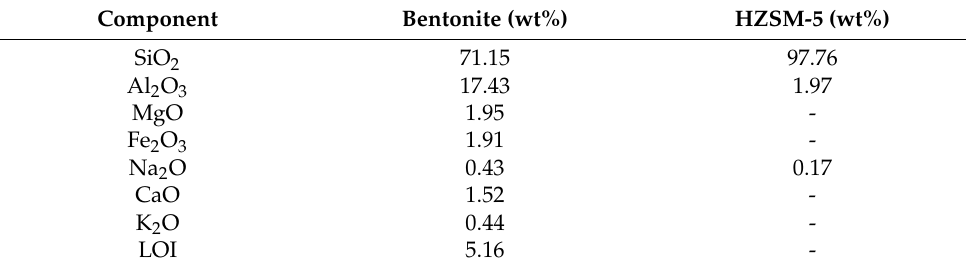
Table 2. Compositions of bentonite and HZSM-5 zeolite.